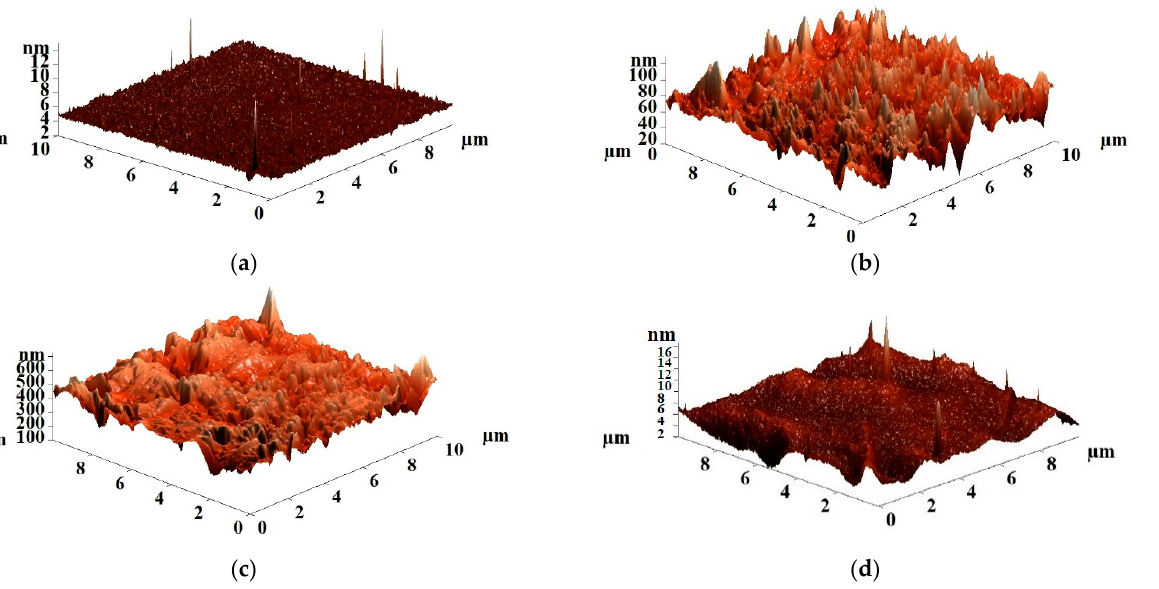
Figure 8. AFM images of the cross-linked PVA and PVA/Zr-MOFs(10%) membranes: ( a ) PVA/GA; ( b ) PVA+MIL-140A(10%)/GA; ( c ) PVA+MIL-140A-AcOH(10%)/GA; and ( d ) PVA+MIL-140A-AcOH-EDTA(10%)/GA. Surface average (Ra) and root-mean-squared (Rq) roughness of the cross-linked PVA and PVA/Zr-MOFs(10%) membranes are presented in Table 2. Table 2. The values of surface average (Ra) and root-mean-squared surface (Rq) roughness of cross-linked PVA and PVA/Zr-MOFs(10%) membranes.